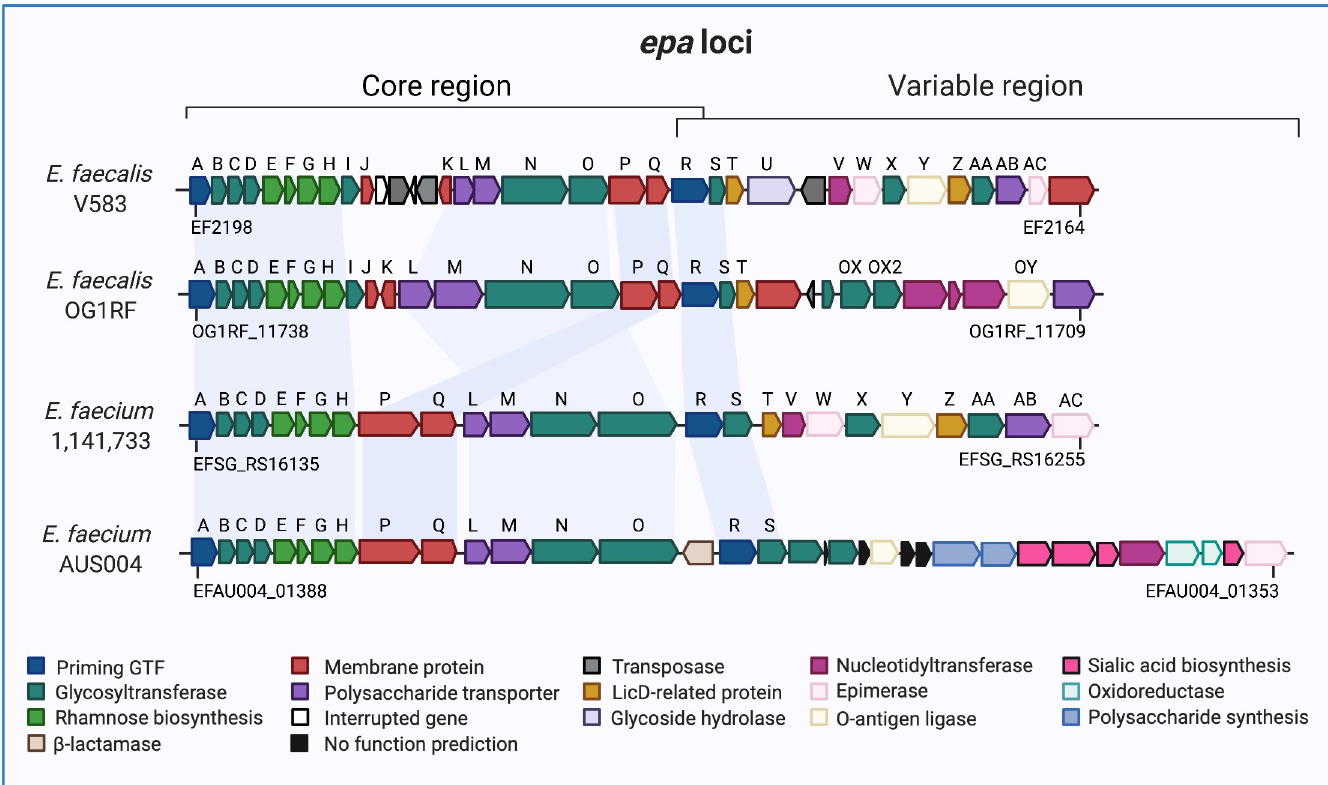
Fig 2. Comparison of predicted epa -like loci among enterococcal strains. In Enterococcus faecalis V583 and OG1RF, EPA biosynthesis is encoded by a cluster of genes organized in 2 genetic loci: first, a conserved region, consisting of 18 genes, from epaA to epaR , which participate in the rhamnan backbone biosynthesis (core region), and, second, a downstream cluster of approximately 10–20 genes exhibiting genetic variability among strains, which has been proposed to account for the major differences on EPA decoration among E . faecalis isolates (variable region) [10,14,32,105]. The core region of Enterococcus faecium is differentially organized in comparison with the EPA core from E . faecalis . It does not have homologs of epaI , epaJ , and epaK . Instead, it has the 2 genes, epaP and epaQ , located at that site [104,105,107]. E . faecium ’s variable locus is proposed to be divided into 4 main variants based on sequence similarities [104,107].The scheme depicts variants 2 and 4 for strains 1,141,733 and Aus0004, respectively. Arrow colors correspond to colored boxes (bottom) and indicate predicted open reading frame function according to genome annotations and BLASTP analysis. Blue shades connect homologs of different strains. The absence/variability of epa genes suggests that the EPA polysaccharides of the 2 species have different sugar compositions, and, in consequence, may confer diverse physiological functions. The epa loci were adapted from [10,20,32,54,104,105,107]. All genes are drawn to scale. EPA, enterococcal polysaccharide antigen; GTF,